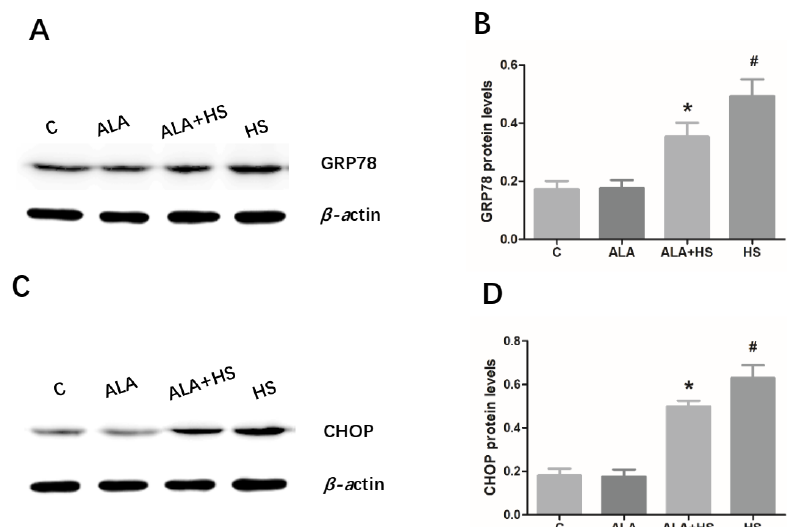
Figure 3. The effect of alpha lipoic acid on endoplasmic reticulum (ER) stress markers in the testes of chickens exposed to heat stress. Western blotting analysis of the expression of ER stress markers, ( A ) glucose-regulated protein 78 (GRP78) and ( C ) CCAAT/enhancer binding protein homologous protein (CHOP). ( B ) GRP78 and ( D ) CHOP protein expression levels were normalized to β-actin levels. The statistical analysis results are shown as bar graphs. The data are presented as the mean ± SE of three independent experiments. Note: * p < 0.05 vs. HS group; # p < 0.05 vs. C group.